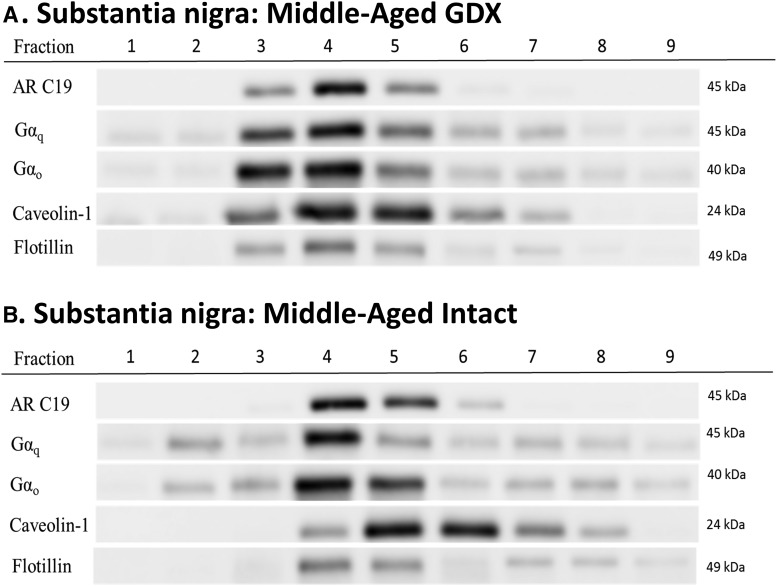
Aged male rats express AR45 protein in membrane lipid rafts. Middle-aged rats (9- to 12-mo old retired breeders) were either gonadectomized (A) or gonadally intact (B). Membrane portion of the substantia nigra micropunch tissue was isolated, and then separated into nine fractions using a sucrose gradient. AR45 (AR-C19 antibody), Gαq and Gαo, and lipid raft markers (caveolin-1 and flotillin) were examined. AR45 expression was observed only in lipid raft fractions, regardless of hormone status. Gαq and Gαo was observed throughout the membrane in both gonadectomized and gonadally intact males. Protein expression of Gαi1-3, Gαs, or full-length (110-kDa) AR were not observed in the substantia nigral membranes of aged male rats (data not shown). GDX, gonadectomy; intact, gonadally intact. n = 3 per treatment group.